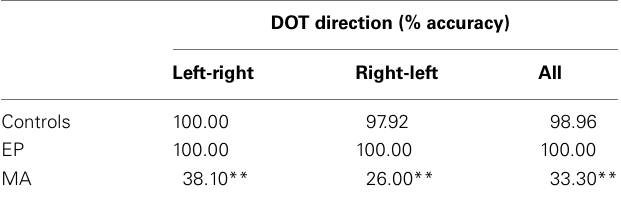
Table 3 | Comparisons between the accuracy (% correct) of each one of the two patients affected by USN and ND and four right-brain-damaged patients without USN and ND (controls), in the conditions where the dot moved from left to right, from right to left, and in the two conditions together. DOT direction (% accuracy)